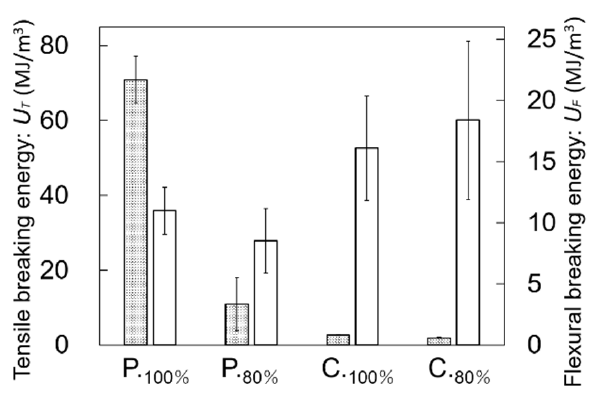
Figure 14. Tensile and flexural breaking energies of the non-immersed test pieces. Average ± S.D., N = 5.